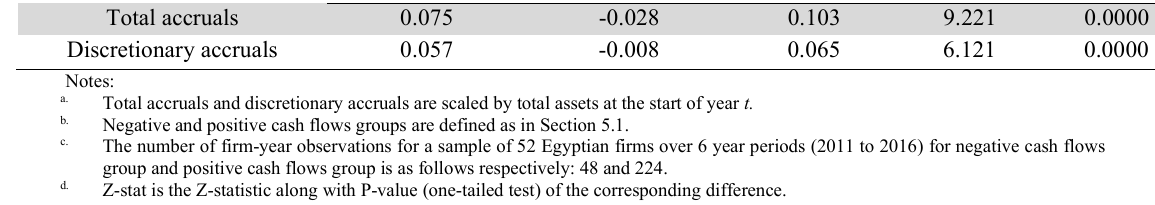
Median accruals (total accruals and discretionary accruals) difference tests Accruals Median (1) Negative cash (2) Positive cash Difference flows group flows group (1-2) Total accruals Discretionary